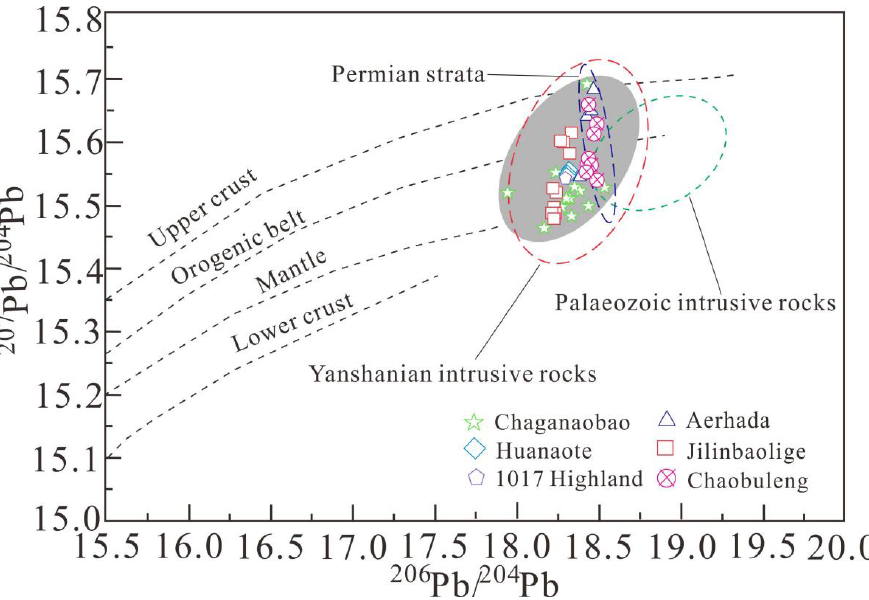
Figure 7. Comparison of the lead isotopic compositions of the Jilinbaolige deposit with other deposits in the central-southern parts of the Great Xing’an Range, as well as the Paleozoic and